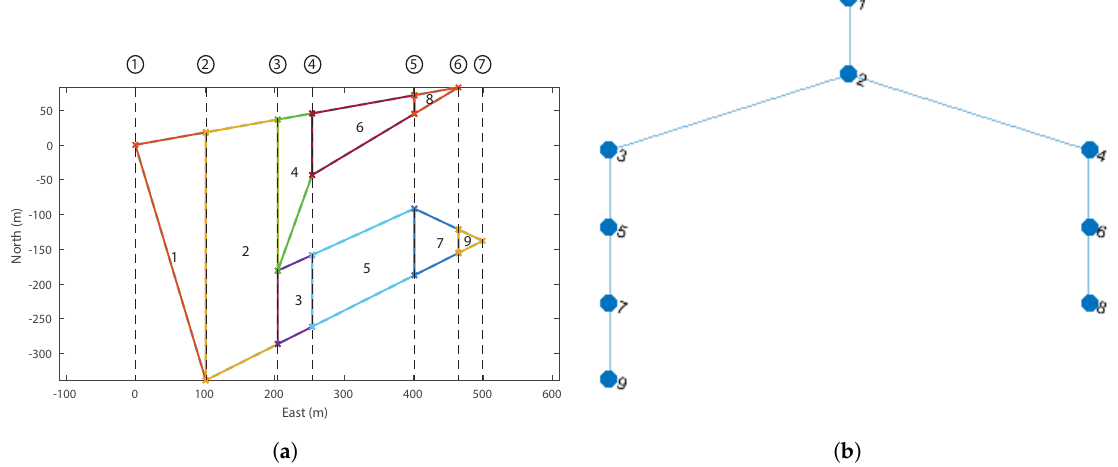
Figure 8. Example trapezoidal decomposition. ( a ) trapezoidal decomposition of polygon, showing vertical slice lines generated at each vertex; ( b ) cell connectivity graph of the example trapezoidal decomposition, where each node represents a decomposed cell, and each edge a cell